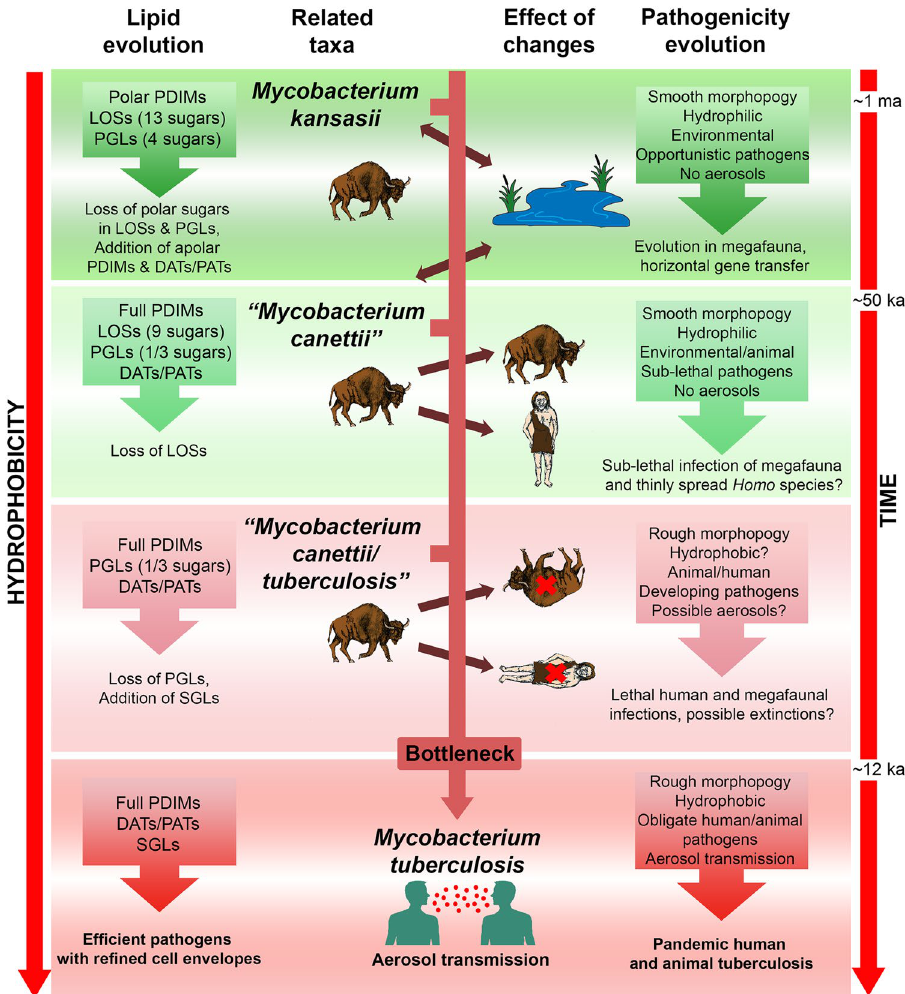
Figure 1. The importance of lipid composition and hydrophobicity in the evolution of tubercle bacilli. Abbreviations: PDIMs, phthiocerol dimycocerosates; LOSs, lipooligosaccharides, PGLs, glycosyl phenolphthiocerol dimycocerosates (phenolic glycolipids); DATs & PATs, di- & pentaacyl trehaloses; SGLs, sulfoglycolipids. Graded green and red backgrounds indicate environmental and mammalian pathogen associations, respectively. Evolution cannot take place directly from modern M. kansasii and “ M. canettii ”, which are shown as related taxa. The hypothetical transitional taxon, labelled “ Mycobacterium canettii/ tuberculosis ”, possibly corresponds to the well-characterised So93R rough variant of “ M. canettii ” 29 . Increasing hydrophobicity, with time, applies to both lipid composition and whole